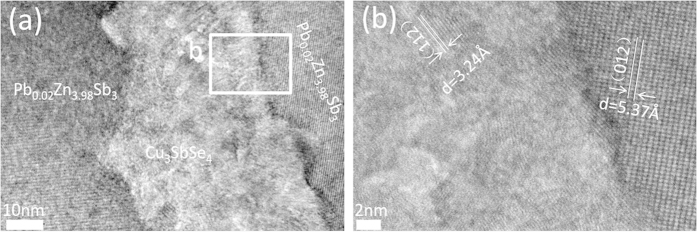
(a) Low-magnification bright-field image of f(Cu3SbSe4)/β-Pb0.02Zn3.98Sb3 with f = 3 vol.%. (b) lattice image of the rectangle area in (a)showing the β-Zn4Sb3 matrix (right), Cu3SbSe4 inclusions (left) and a typical phase boundary (between the matrix and the dispersed phase).